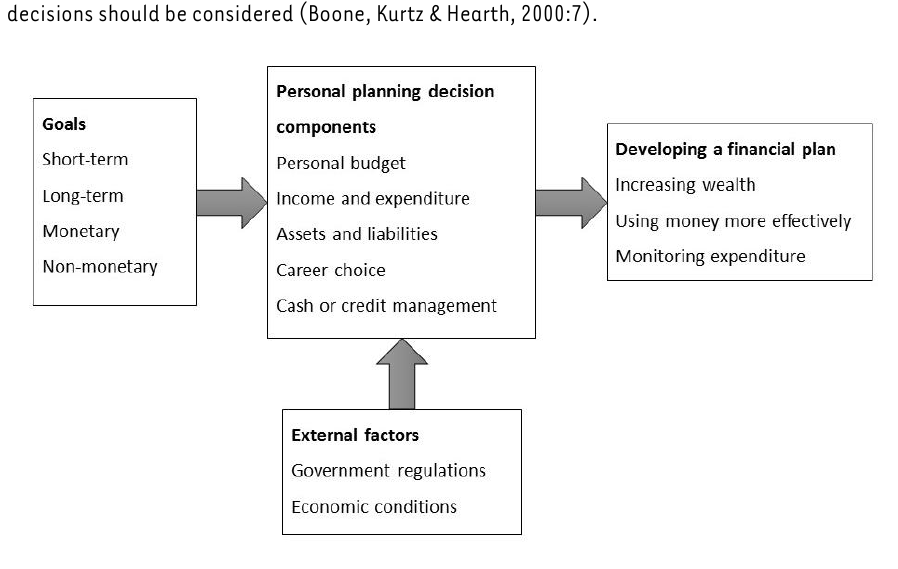
FIGURE 1: Personal financial planning model Source: Boone et al.